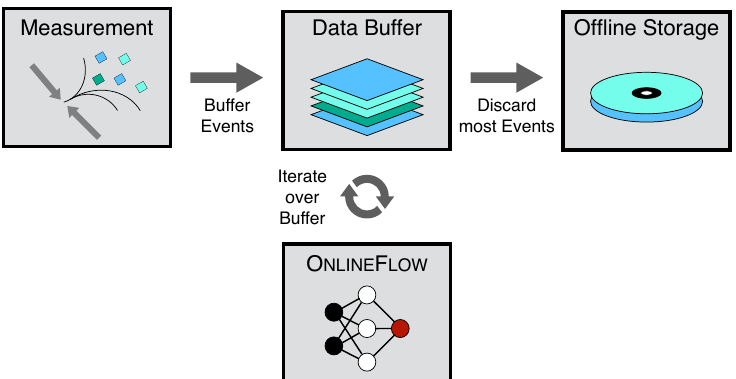
Figure 3: Illustration of our test of the online training. We collect events (left) into a buffer (top center). In the classic prescale approach most events are discarded, only a small fraction is saved for offline analysis (right). Our O NLINE F LOW (bottom center) is trained online on the data in the buffer and iterated until the buffer is